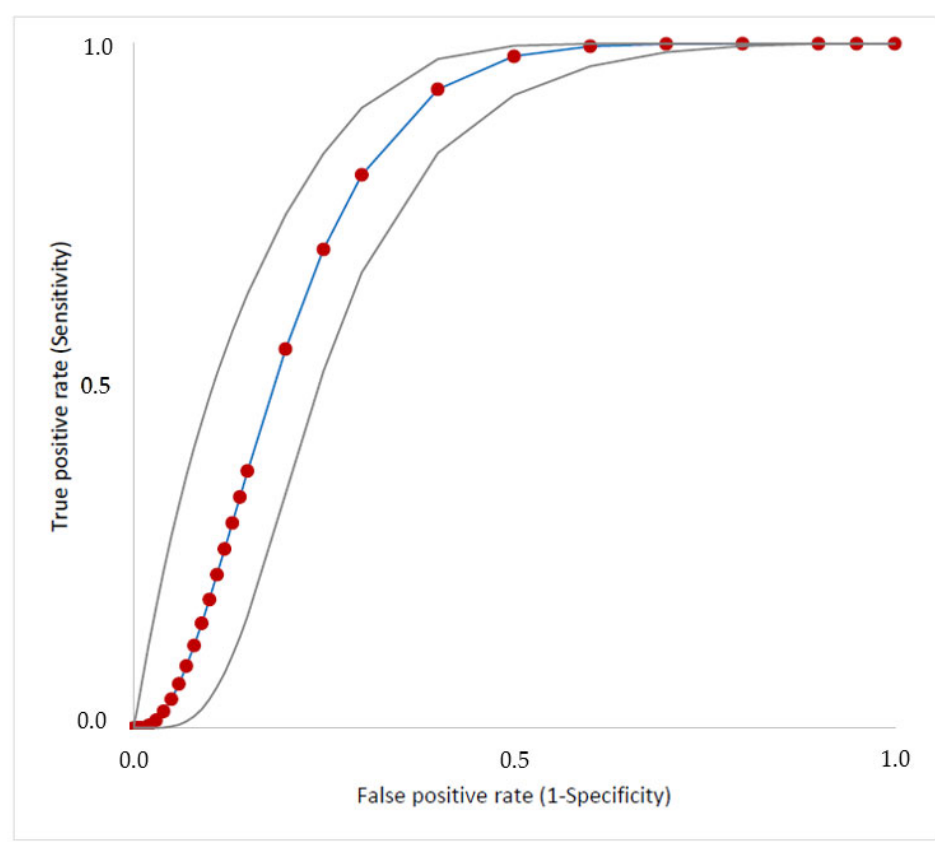
Figure 3. Receiver operating characteristic curve for the prediction of CR-GNB in sepsis as a function of the four-point score defined in Supplementary Table S2. Area under the curve of 0.80 (95% CI: 0.76–0.85, p < 0.001). Upper and lower boundaries are shown in gray. Table 3. Accuracy of the predictive score for the identification of CR ‐ GNB sepsis, stratified by cutoff values of the score.